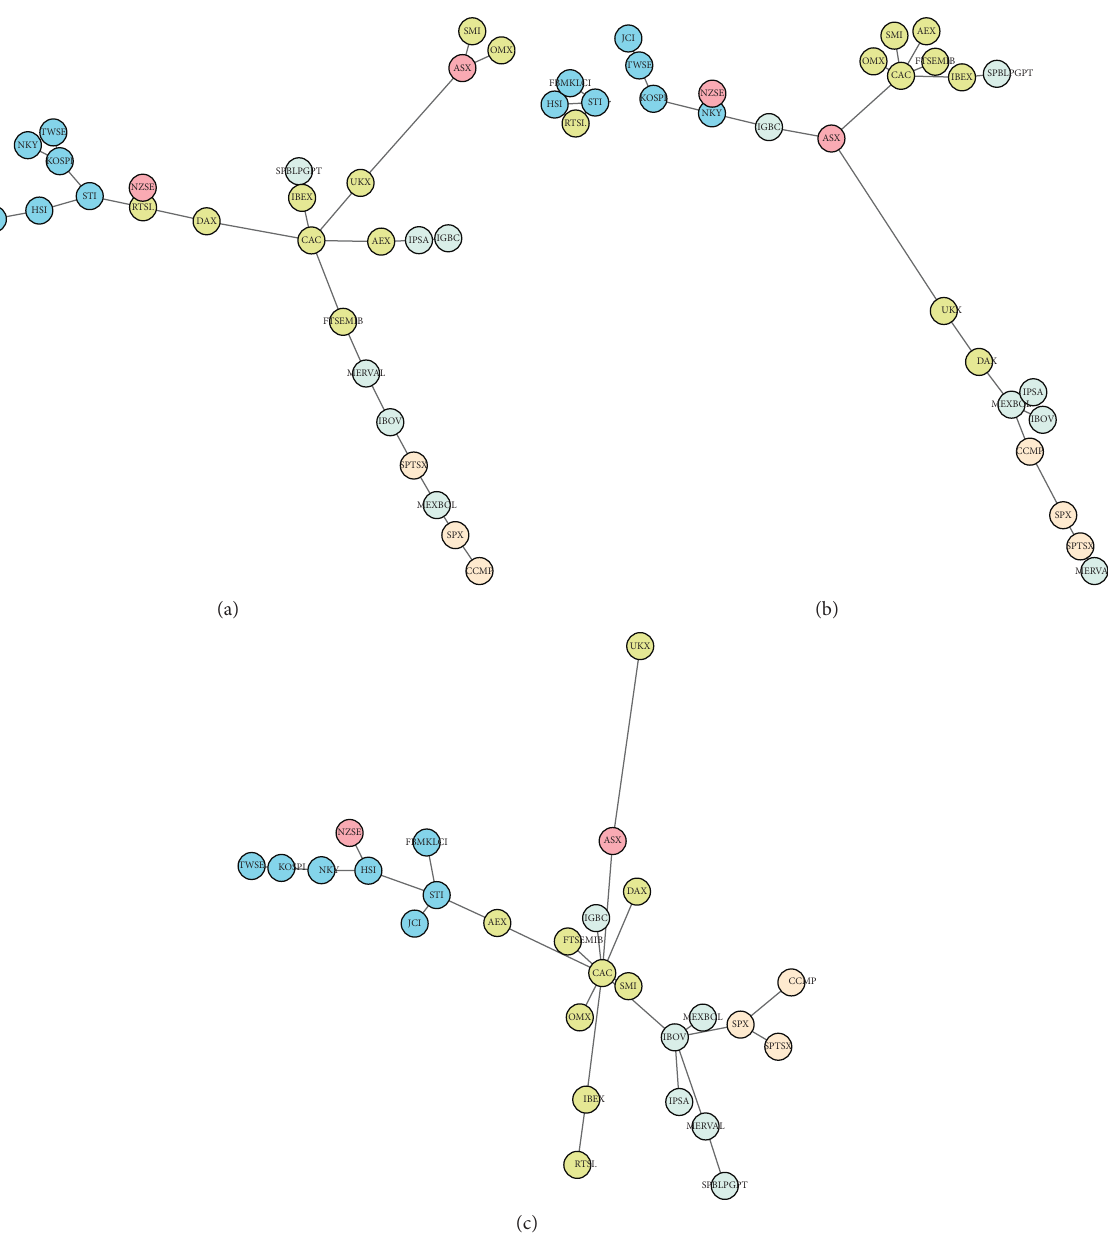
Figure 1: The resulting MSTs for three different periods. (a) Precrisis (January, February, and March 2008), (b) crisis (September, October, and November 2008), and (c) postcrisis (March, April, and May 2009). The color of the vertex represents different regions: blue: Asia, light blue: Latin America, light yellow: Europe, light Salmon: North America, and pink: